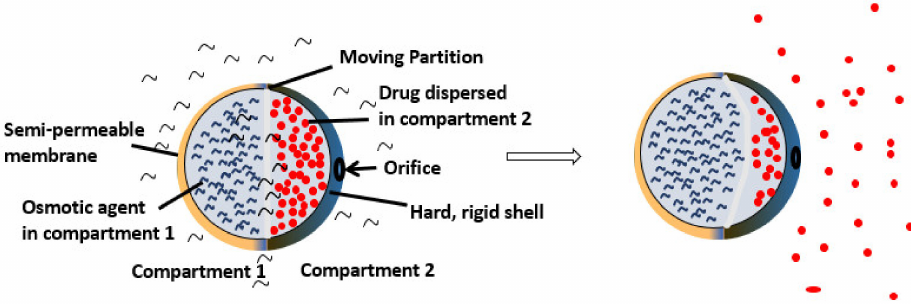
Figure 27. Schematic of osmotic pressure-controlled drug delivery system.